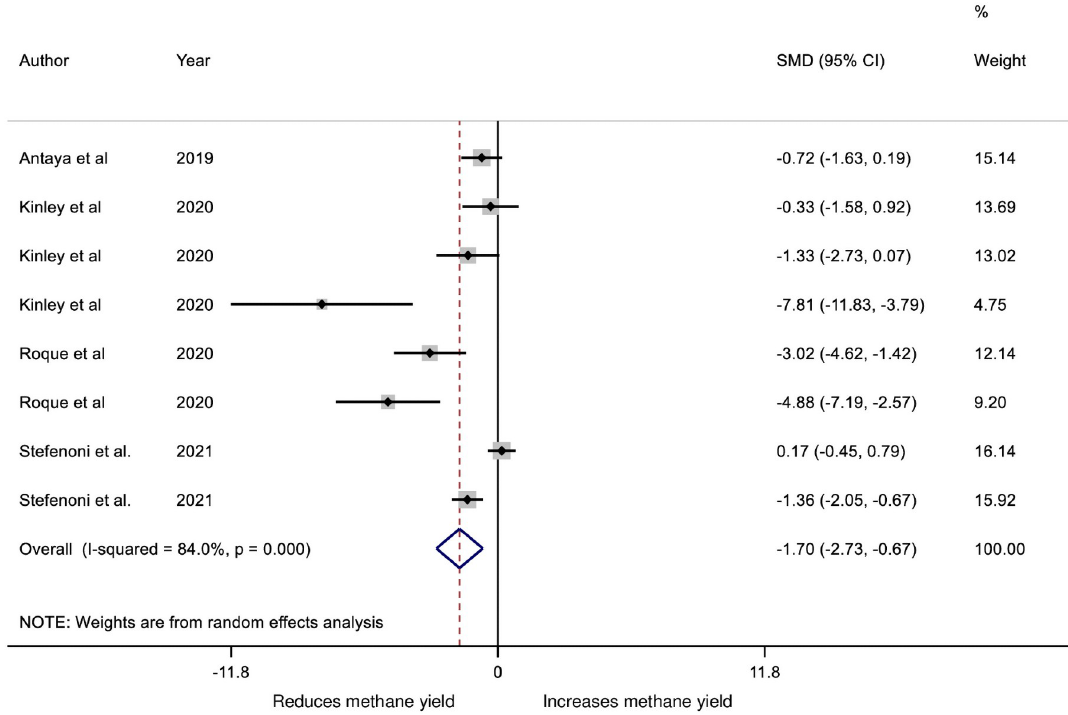
Fig 4. Forest plot of the effect size or Standardized Mean Difference (SMD; standardized using the z-statistic) and 95% CI of the effect of seaweed intervention on methane yield from cattle. The solid vertical line represents a mean difference of zero or no effect. Points to the left of the line represent a reduction in methane yield, while points to the right of the line indicate an increase. Each square around the point effect represents the mean effect size for that comparison and reflects the relative weighting of the comparison to the overall effect size estimate. The larger the box, the greater the comparison contribution to the overall estimate. The weights that each comparison contributed are in the right-hand column. The upper and lower limit of the line connected to the square represents the upper and lower 95% CI for the effect size. The overall pooled effects size or SMD and 95% CI pooled using the DerSimonian and Laird (D+L) [23] and robust meta-analytical random effects models [18, 26] are indicated by the respective diamonds at the bottom. The heterogeneity measure, I 2 is a measure of residual variation among comparisons included in the meta-analysis. Methane yield was considerably heterogeneous as indicated by the overall I 2 of 84.0%.